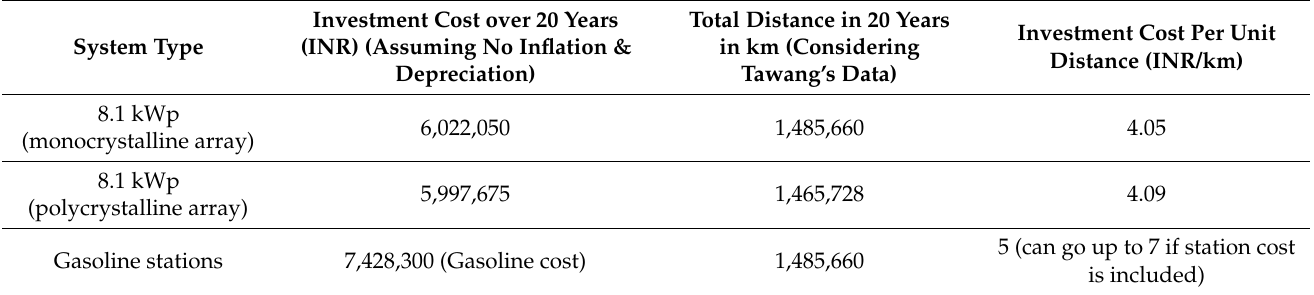
Table 6. Investment cost per km